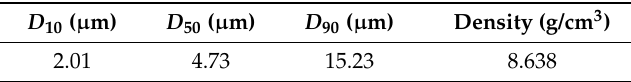
Table 1. Particle size and density of the copper